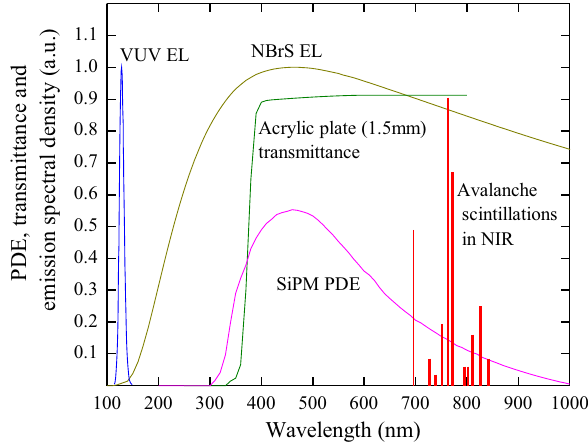
Fig. 1 Photon emissionspectraingaseous Ardue toordinary scintilla- tions in the VUV measured in[22], NBrS electroluminescenceat 8.3 Td theoretically calculated in [15] and avalanche scintillations in the NIR measured in [17,18]. Also shown are the photon detection efficiency (PDE) of the SiPMs (MPPC 13360-6050PE [23]) at an overvoltage of 5.6 V obtained from [24] and the transmittance of the acrylic plate (1.5 mm thick) in front of the SiPM matrix, used in this study